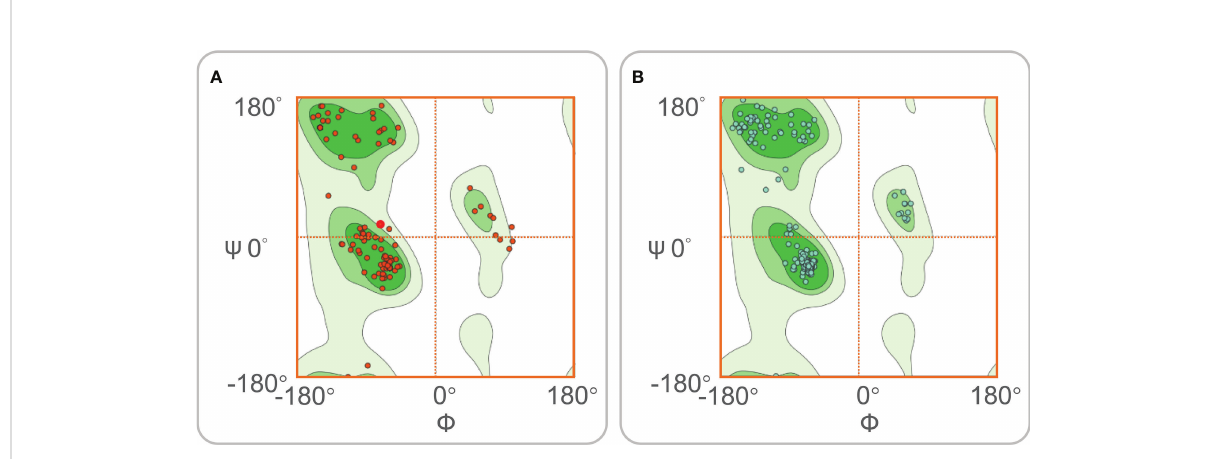
FIGURE 2 Ramachandran diagrams for the MP3RT vaccine. Ramachandran map is a method of visualizing energy preference regions, which can be used to see if protein structure is reasonable. The dark green area is the favored region. The other two green areas are the outlier region. The white area is the rotamer region. The rotamer region can be interpreted as the high-energy region, and the protein needs to spend some energy to drive the residues into this region. (A) Before optimization, the Ramachandran diagram showed that the favored region, outlier region, and rotamer region of the MP3RT vaccine were 91.34%, 3.15%, and 5.32%. (B) After optimization, the Ramachandran diagram showed that the favored region, outlier region, and rotamer region of the MP3RT vaccine were 98.22%, 0.36%, and 0.99%,